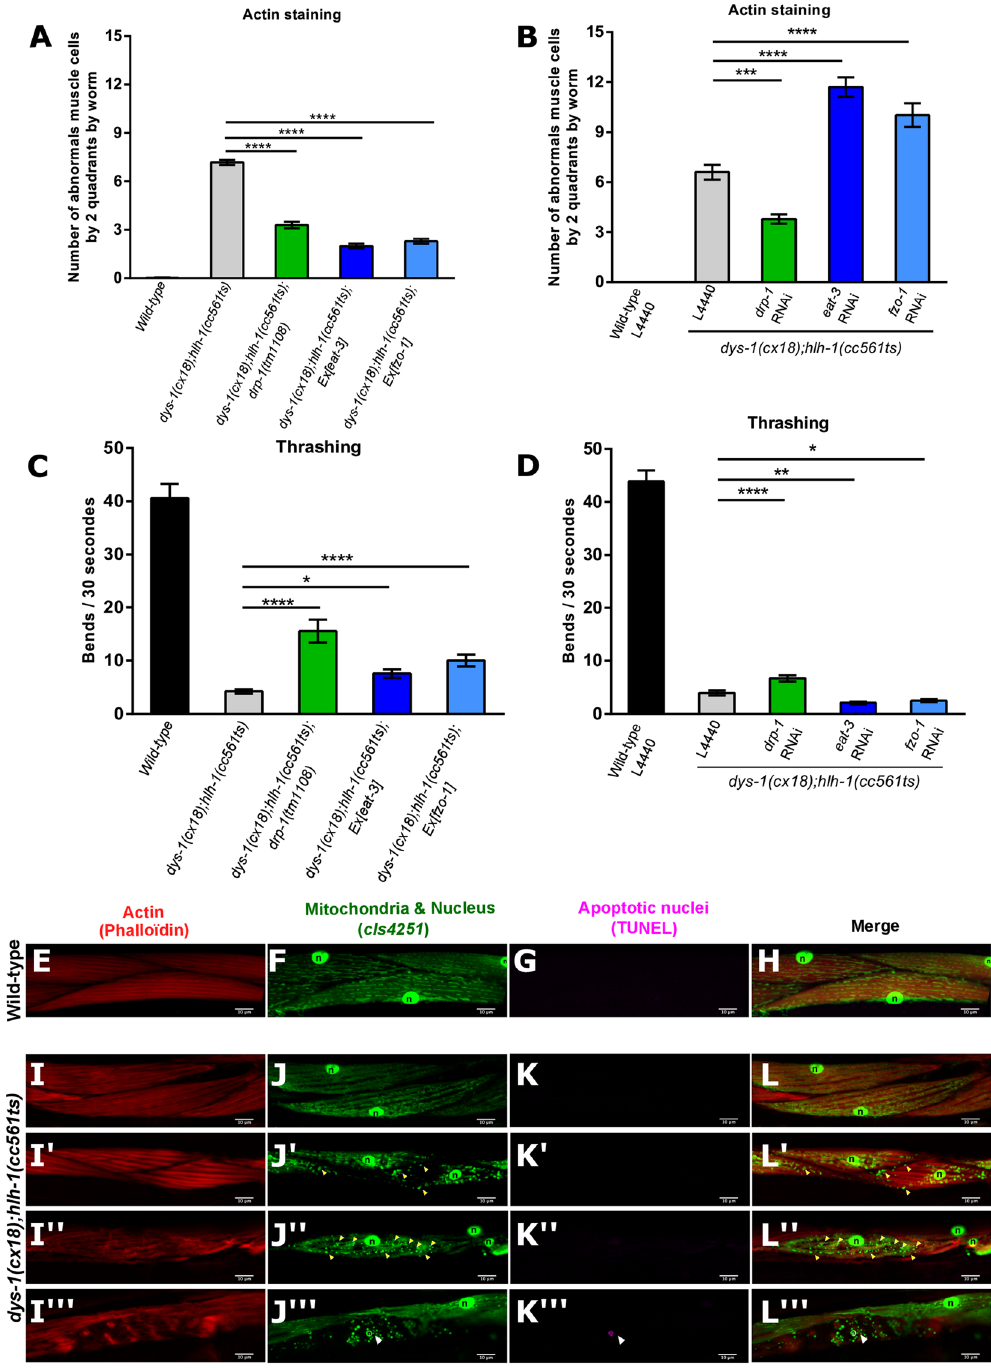
Figure 2. DRP-1 induces dystrophin-dependent muscle degeneration and locomotion defects. ( A ) Number of abnormal C. elegans body wall muscle cells by two quadrants quantified by phalloïdin staining in wild-type worms, dys-1(cx18);hlh-1(cc561ts) mutant worms, or dys-1(cx18);hlh-1(cc561ts) mutant worms with drp- 1(tm1108) mutation or overexpression of eat-3 or fzo-1 (n = 70 worms at least). ( B ) Number of abnormal C. elegans body wall muscle cells by two quadrants quantified by phalloïdin staining in dys-1(cx18);hlh-1(cc561ts) mutant worms fed either with the empty vector L4440 or with RNAi constructs targeting drp-1 or eat-3 or fzo-1 (n = 60 worms at least). ( C ) Quantification of worm trashing in wild-type worms, dys-1(cx18);hlh-1(cc561ts) mutant worms or dys-1(cx18);hlh-1(cc561ts) mutant worms with drp-1(tm1108) mutation or overexpression of eat-3 or fzo-1 (n = 25 worms at least). ( D ) Quantification of worm trashing in dys-1(cx18);hlh-1(cc561ts) mutant worms fed with the empty vector L4440 or with drp-1 RNAi or eat-3 RNAi or fzo-1 RNAi (n = 100 worms at least). All the experiments were performed on L4 + 3 day-old worms. One-way ANOVA, Tukey’s multiple comparisons test. Data represent the mean obtained by pooling at least three independent assays. Errors bars represent SEM * p < 0.05 ** p < 0.01 *** p < 0.001 **** p < 0.0001 ns. indicates that the mean is